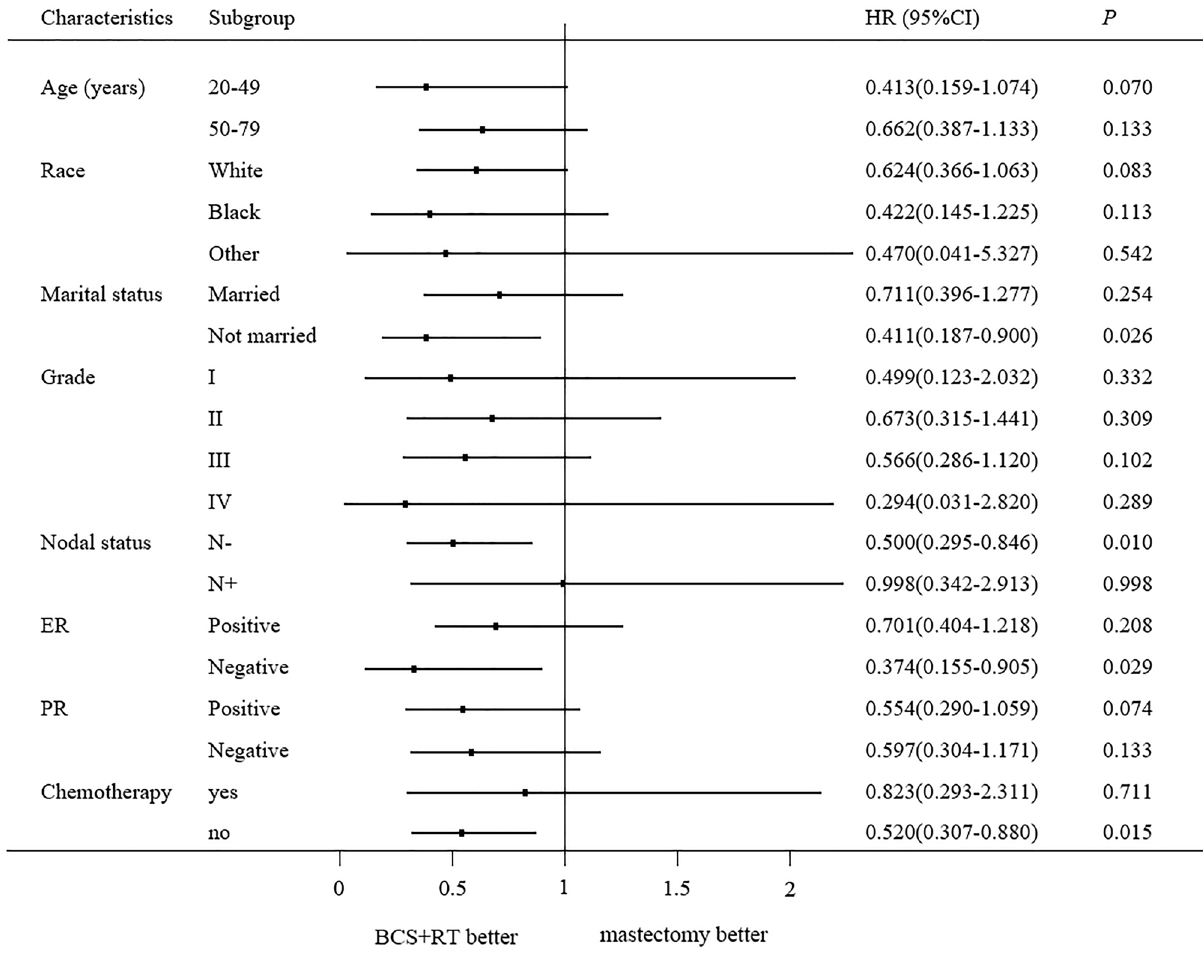
Figure 4. The forest plot of HR for BCSS between the BCS + RT group and mastectomy group according to different